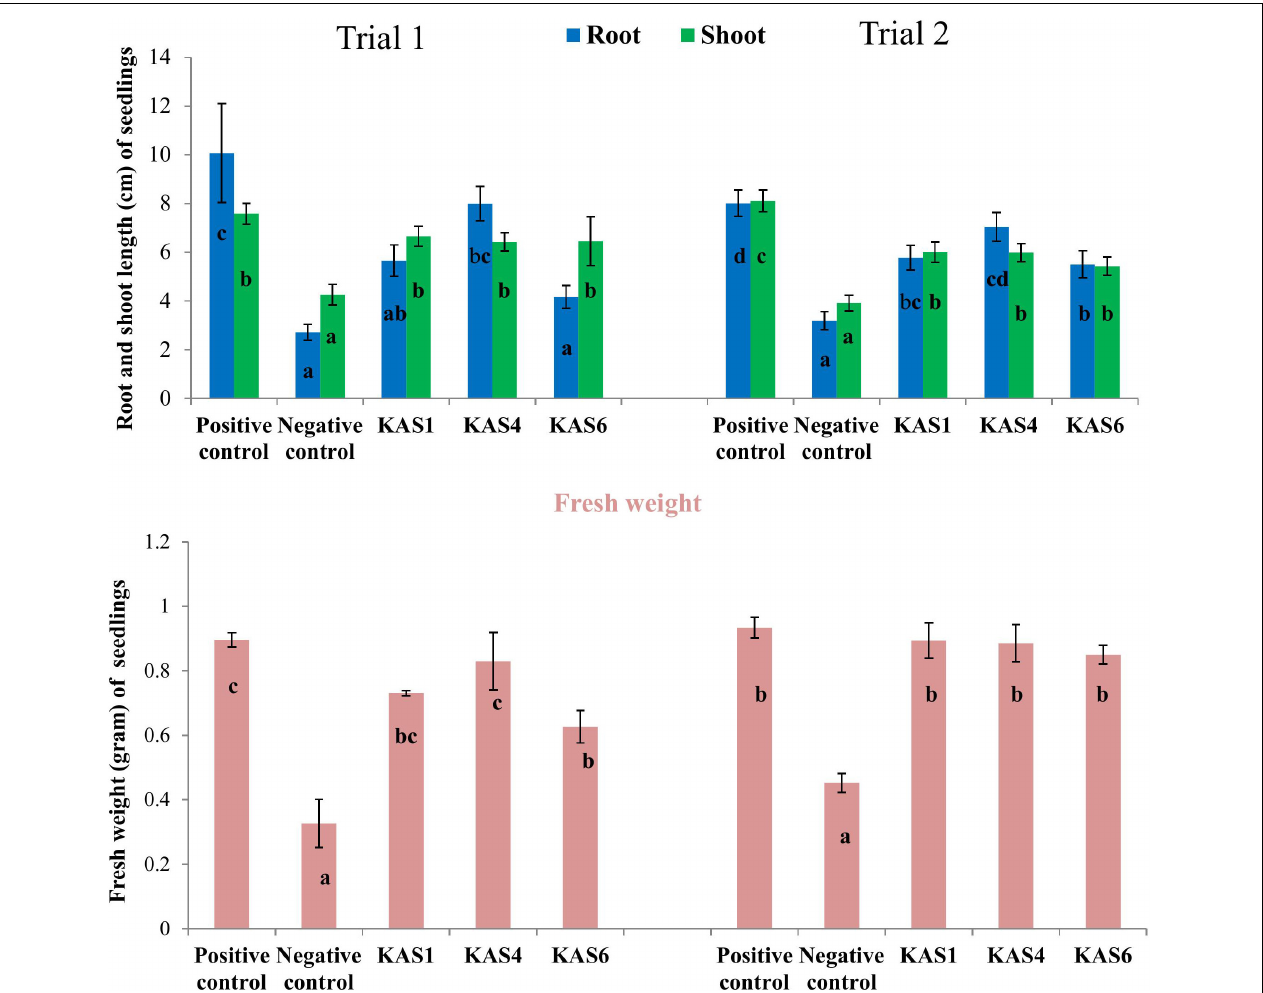
FIGURE 2 | Effect of removal and re-inoculation of SEB on the root-shoot length and fresh weight of seedlings. Positive control: where seeds were treated only with NaOCl; Negative control: where seeds were treated with NaOCl + antibiotic; KAS1, KAS4, and KAS6: where seeds initially treated NaOCl + antibiotic then inoculated with strains KAS1, KAS4, and KAS6. Different letters represent the significant differences among the means of treatments ( N = 30, P ≤ 0.05). Experiment was repeated in two trials ( Trial 1 and Trial 2 ) .